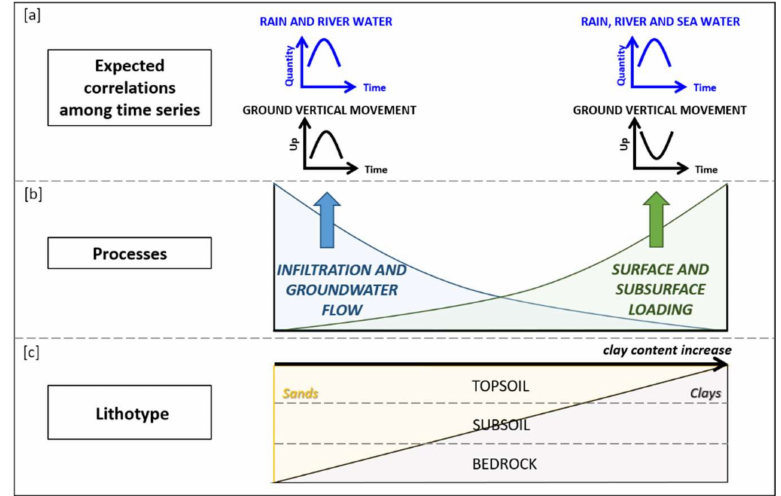
Figure 2. Periodic component of land vertical motion: ( a ) expected time series correlation in delta areas; ( b ) expected elastic responses; ( c ) simplified lithological layering at the base of the associated physical